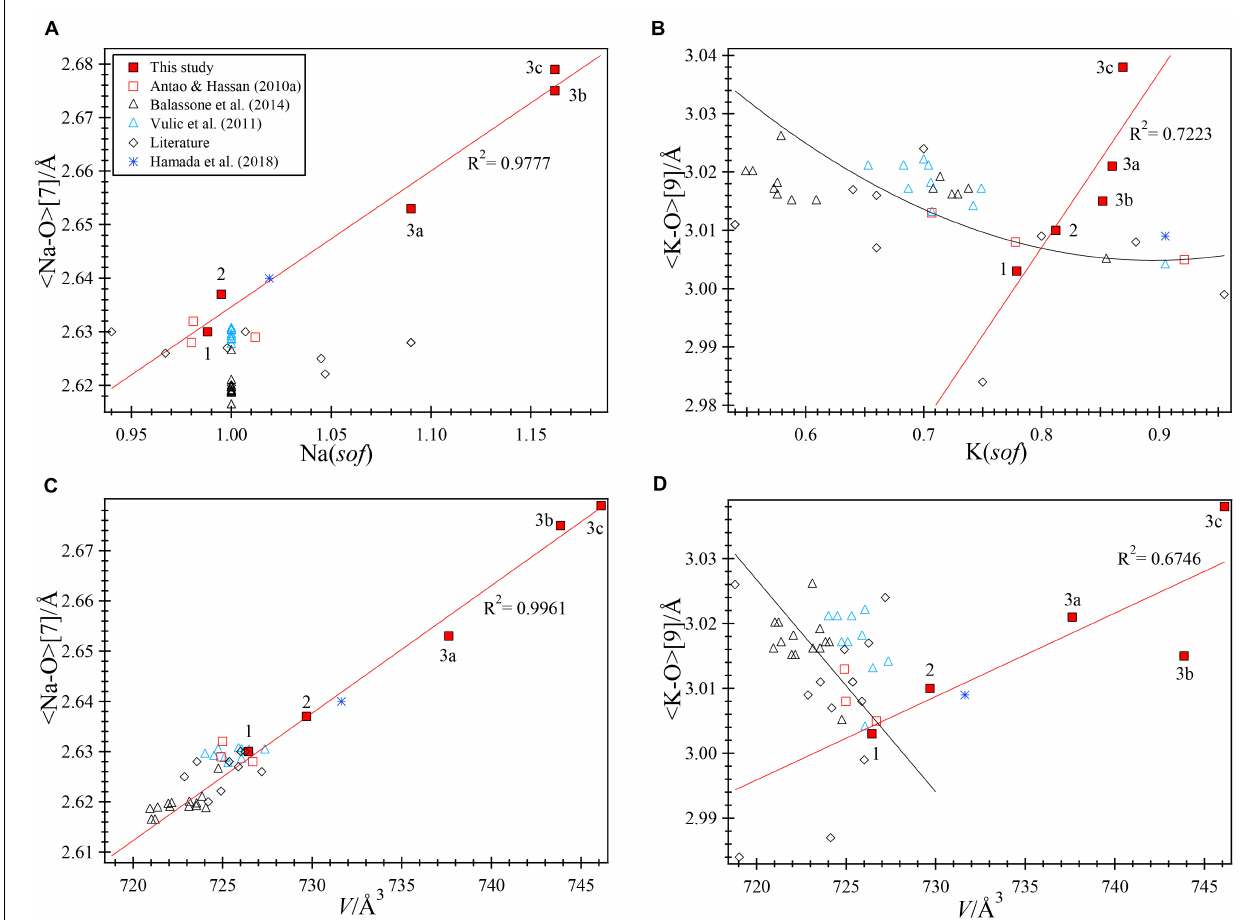
FIGURE 7 | Structural variations in natural nepheline samples. The linear red trend lines are based on data for the three samples from this study containing five data points (1, 2, 3a, 3b, and 3c). The black trend lines are fitted to the three samples from Bancroft (Antao and Hassan, 2010b). (A) A good linear relation is observed between < Na-O > [7] and Na( sof ) with R 2 = 0.9777, but data for many other natural nepheline samples from the literature do not fall close to this trend line. “Literature” sources are given in the text. Note that Na( sof ) > 1 for some of the samples from the literature. (B) A linear relation occurs between < Na-O > [7] and